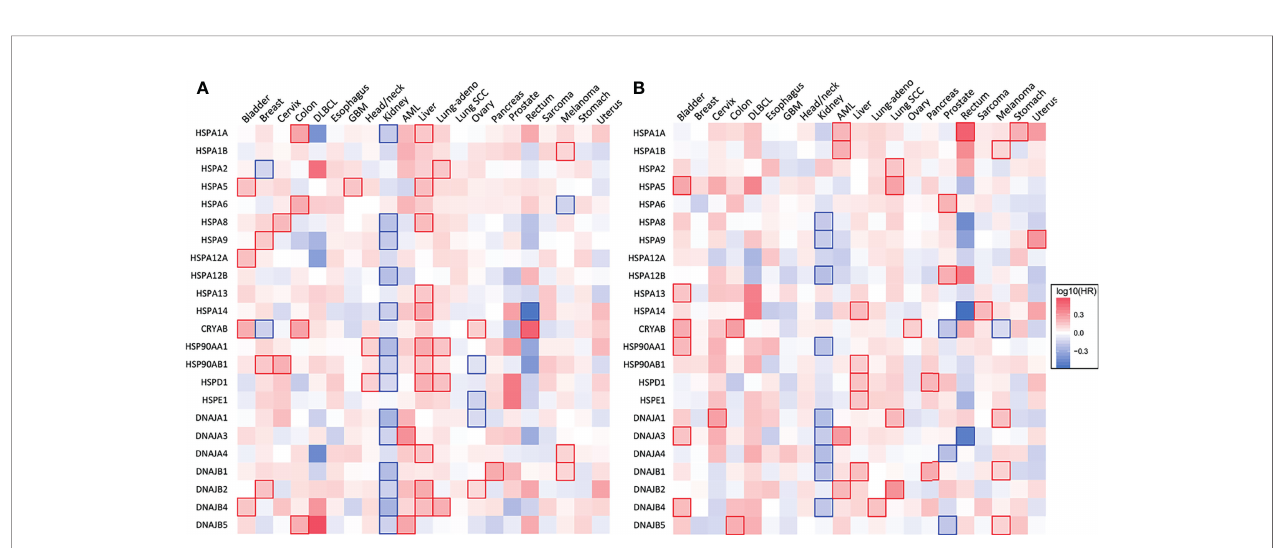
FIGURE 2 | Heat shock gene expression and survival across 21 types of human cancers. (A) Heatmap showing the relationship between heat shock gene expression and the overall survival and (B) disease-free survival of patients. Patients were divided into groups with high and low mRNA expression at median. Each heatmap cell corresponds to a log 10 HR (hazard ratio) for respective cancer type. Cells marked with shades of red: HR>0, blue cells: HR<0. Statistically signi fi cant relationships are marked with blue or red cell borders. Signi fi cance level: p<0.05 in log-rank test. Data were accessed through GEPIA (gepia.cancer-pku.cn)